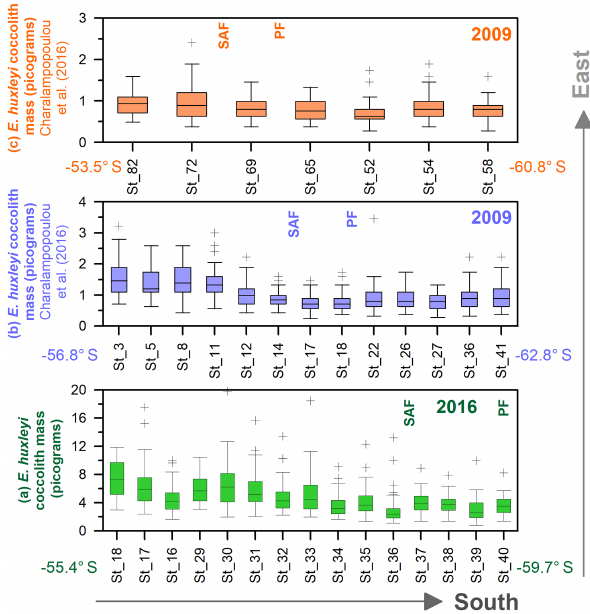
Figure 13. Drake Passage latitudinal transects from east to west, showing box plot coccolith mass estimates (in pg): (a) this study, (b) transect at around 68 ◦ W from Charalampopoulou et al. (2016), and (c) transect at around 55–58 ◦ W from Charalampopoulou et al. (2016). Note that (b, c) have been calculated from Charalam- popoulou et al. (2016). Outliers have been indicated with “ + ”, and numbers on the x axes refer to the original station numbers. The approximate location of the Subantarctic Front (SAF) and Polar Front (PF) are shown as well as the year of the